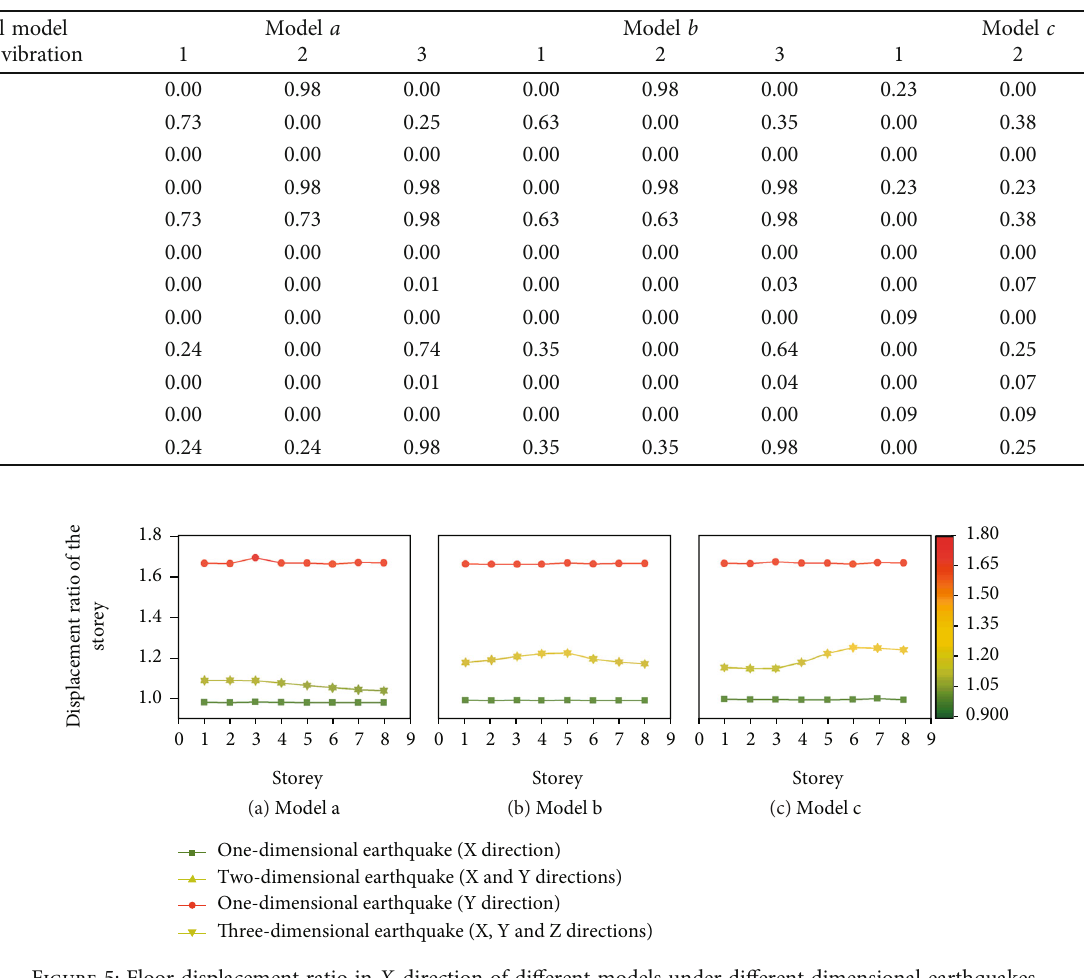
Table 4: Mass participation coe ffi cients of the fi rst three orders of vibration.